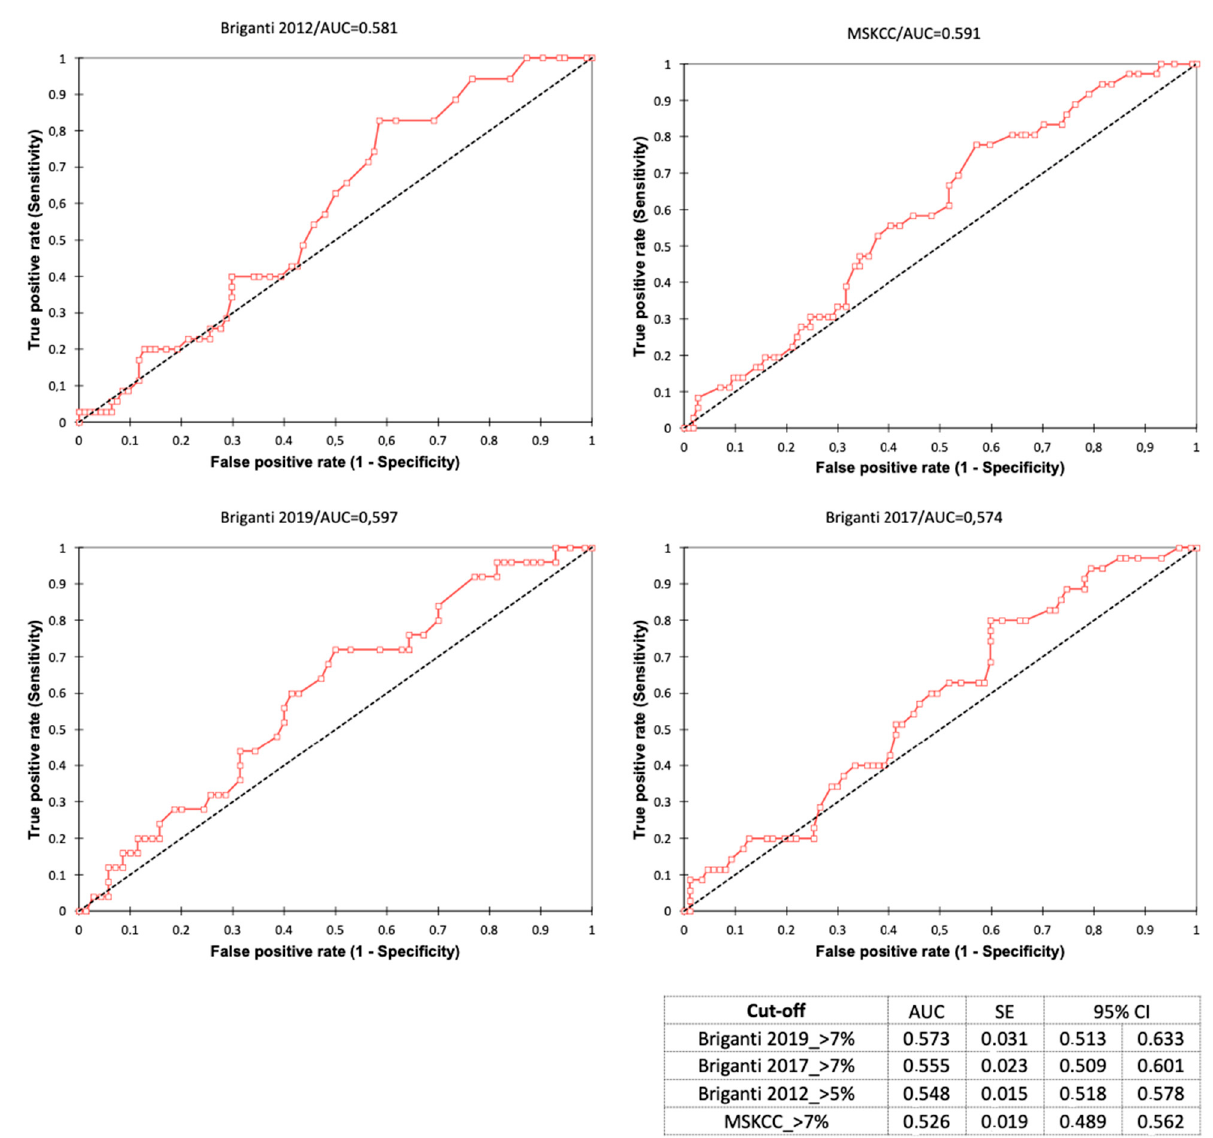
Figure 1. Receiver operating characteristic (ROC) curve and relative Area Under the Curve (AUC) in predicting LNI (pN+) of the currently available MSKCC, Briganti 2012, Briganti 2017, and Briganti 2019 nomograms.